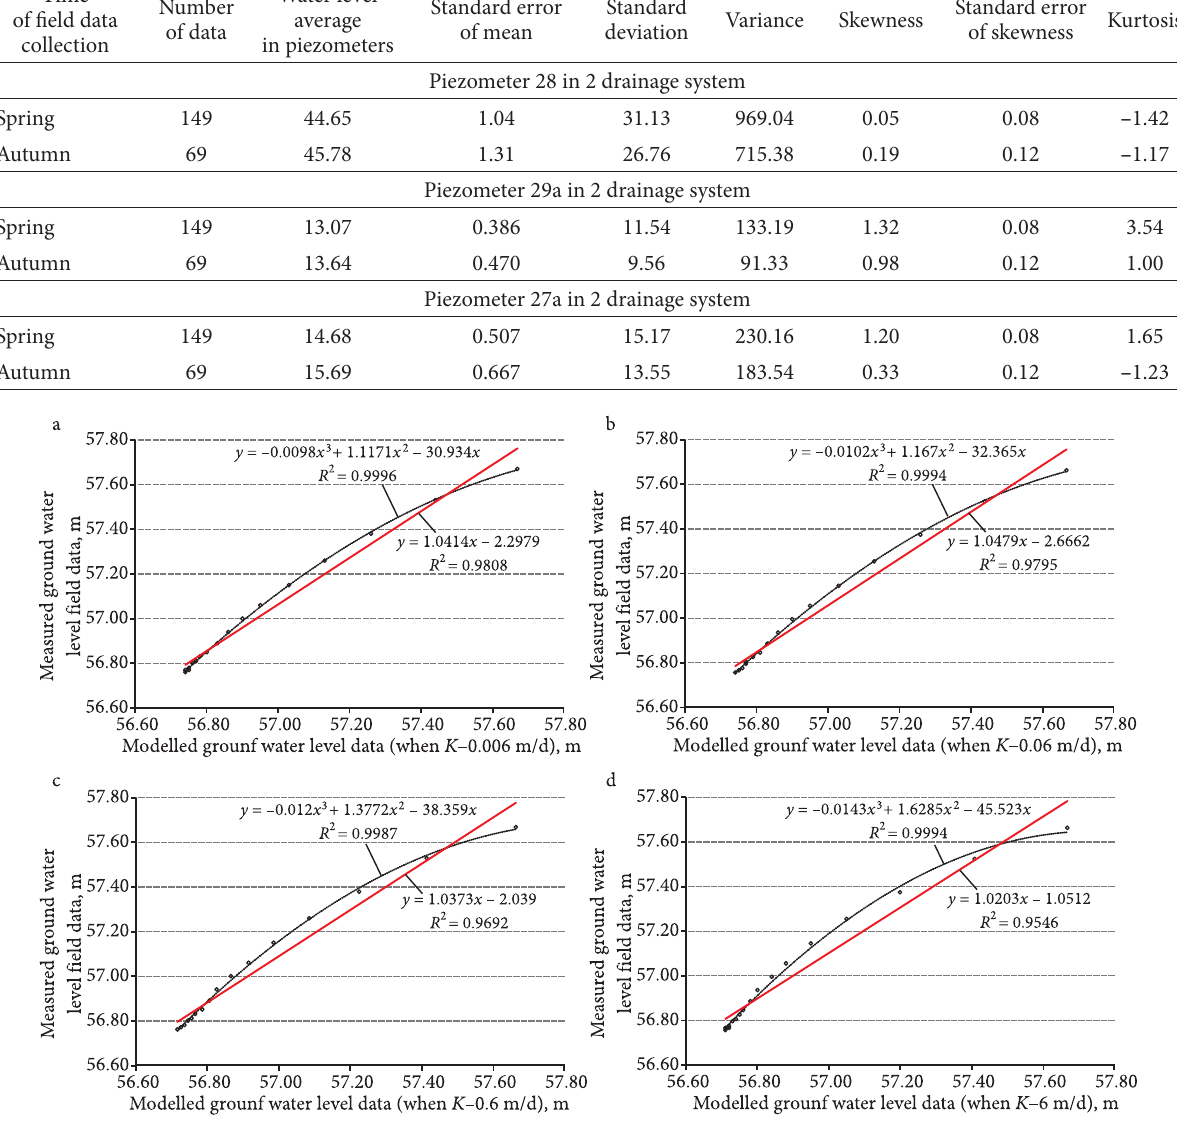
Fig. 4. Impact of the modelled cross drains on the water table depression in area being drained when the spacing between trenches is 20